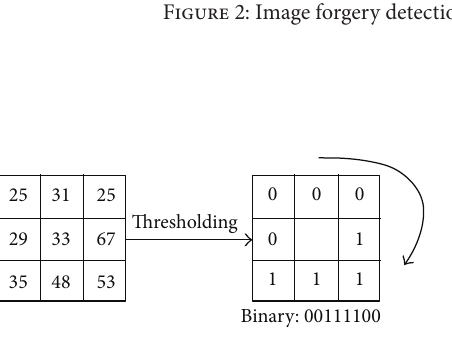
Figure 3: Basic LBP